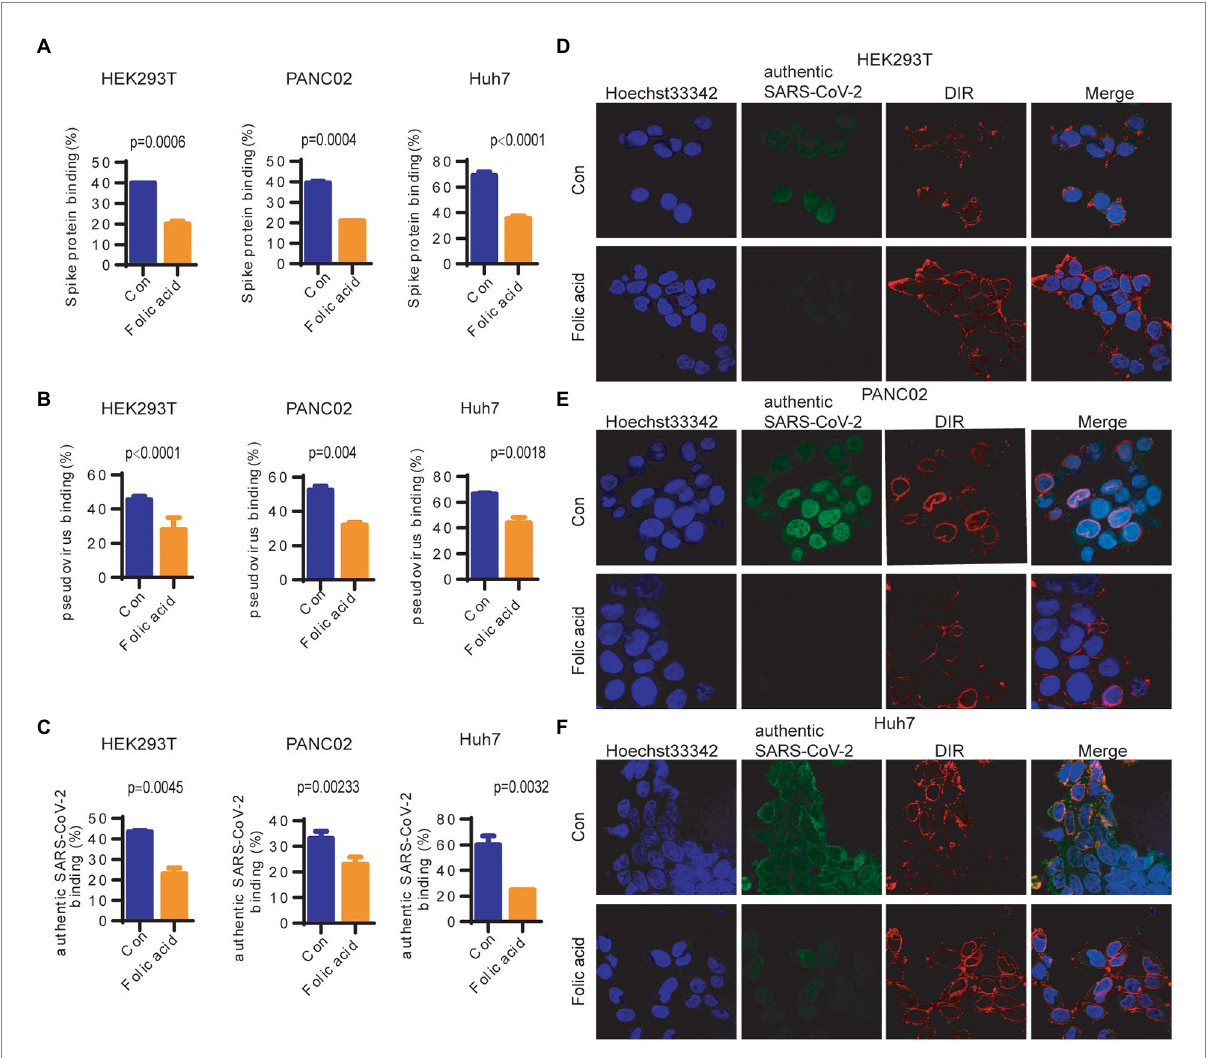
FIGURE 4 The binding ability of SARS-CoV-2 to cells was reduced by folic acid treatment. (A) The binding ability of the Spike protein to cells was reduced to 47.5%/53.8%/50.7% in HEK293T/PANC02/Huh7 cells at a 15,000 pg./ μ L Spike protein concentration. (B) The binding ability of SARS-CoV-2 pseudovirus to cells was reduced to 52.2%/39.2%/29.8% in HEK293T/PANC02/Huh7 cells at 1.5 × 10 6 pseudovirus copies/ml. (C) The binding ability of inactivated authentic SARS-CoV-2 to cells was reduced to 52.2%/29.3%/54.5% in HEK293T/PANC02/Huh7 cells at 10 μ g/ μ l inactivated SARS- CoV-2. The representative image shows that the binding ability of inactivated authentic SARS-CoV-2 to cells was reduced by folic acid treatment, as detected by confocal microscopy in HEK293T (D) PANC02 (E) and Huh7 (F) cells. Cells were treated with 20 μ m folic acid for 48 h, and different concentrations of authentic SARS-CoV-2 were added to the medium and allowed to bind for 1 h. The quantification of binding ability was detected by Celigo assay. The cell membrane was labelled with DiR (red), the spike protein and pseudovirus/authentic SARS-CoV-2 were labelled with an anti-spike antibody (green), and the cell nucleus was labelled with Hoechst (blue). The statistical analysis of virus binding (the fluorescence intensity of Spike protein on cells, Hoechst used as internal control) differences caused by folic acid treatment was performed by two-way